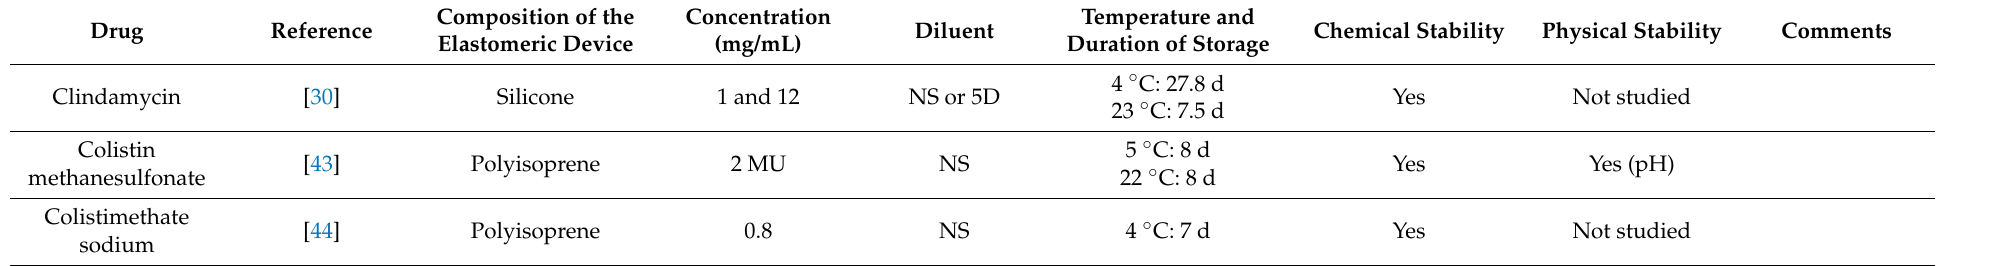
Table 6. Stability of other antibiotics in elastomeric devices.